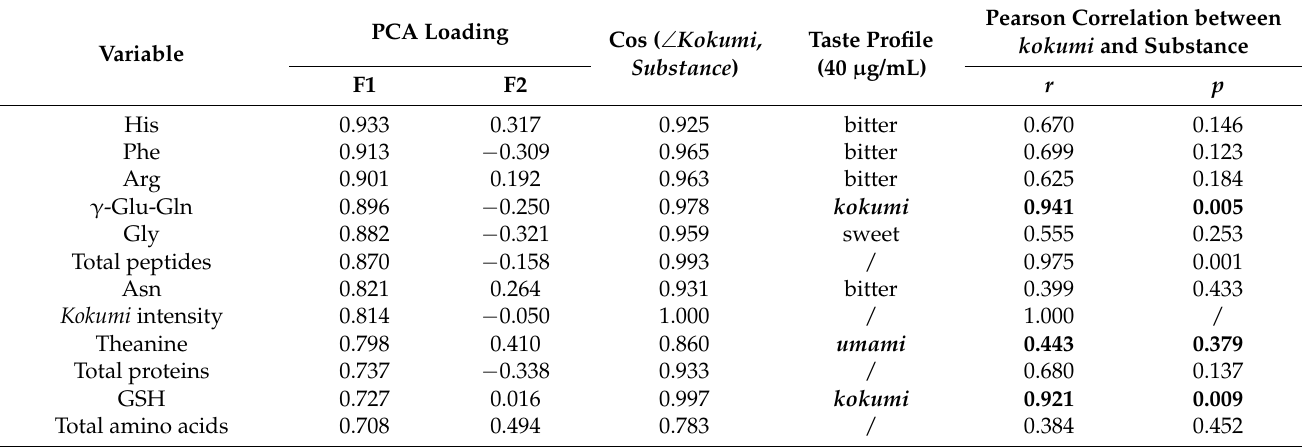
Figure 3. Heatmap of high-kokumi teas (HKs) and (low-kokumi teas) LKs. The color scale bar for each compound indicates the abundance of the compound among six tea samples, and results in the same row are comparable. The normalization method was using Z-score, and where Xzscore = (Xi − Xmean)/Xsd. The abbreviations and full names are as follows: Asp (aspartic